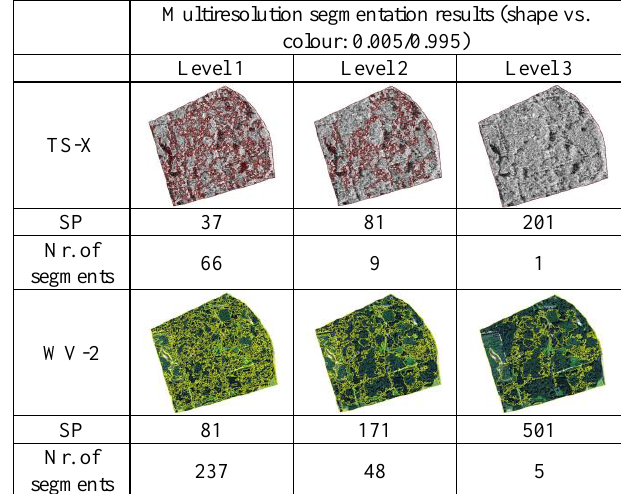
Table 1. Multiresolution segmentation results on the TS-X image from 01 July 2012 and on the WV-2 image. The three levels of segmentation suggested by the ESP tool are shown, whereby the weighing of colour variance has been set to 0.995 as suggested in the